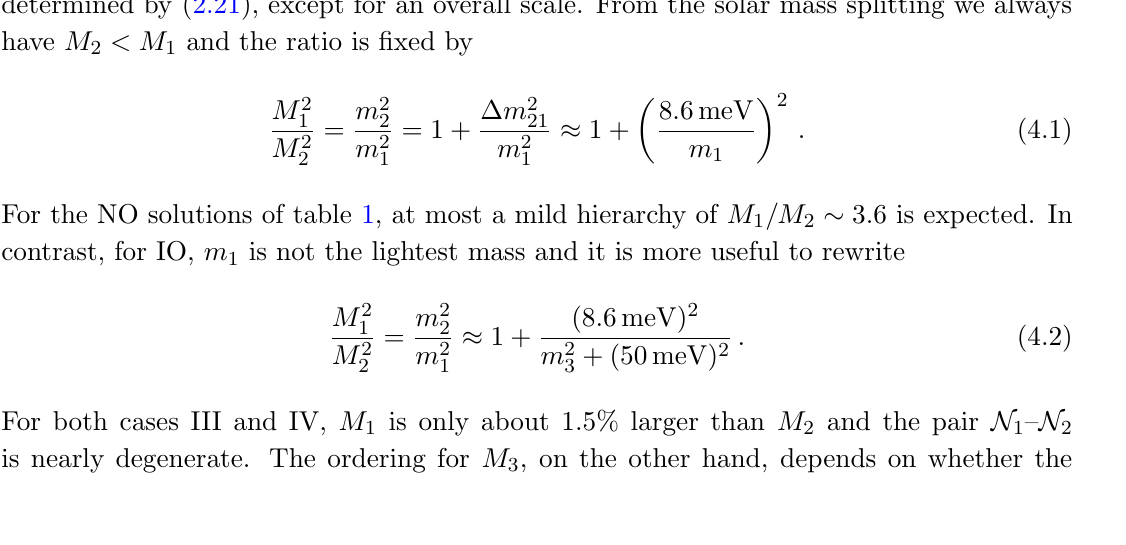
Figure 3 . Correlation between j (cid:1) m 2 neutrino mass matrix with one-zero texture in A ee = ( M (cid:0) 1 are varied within 3- (cid:27) of ref.